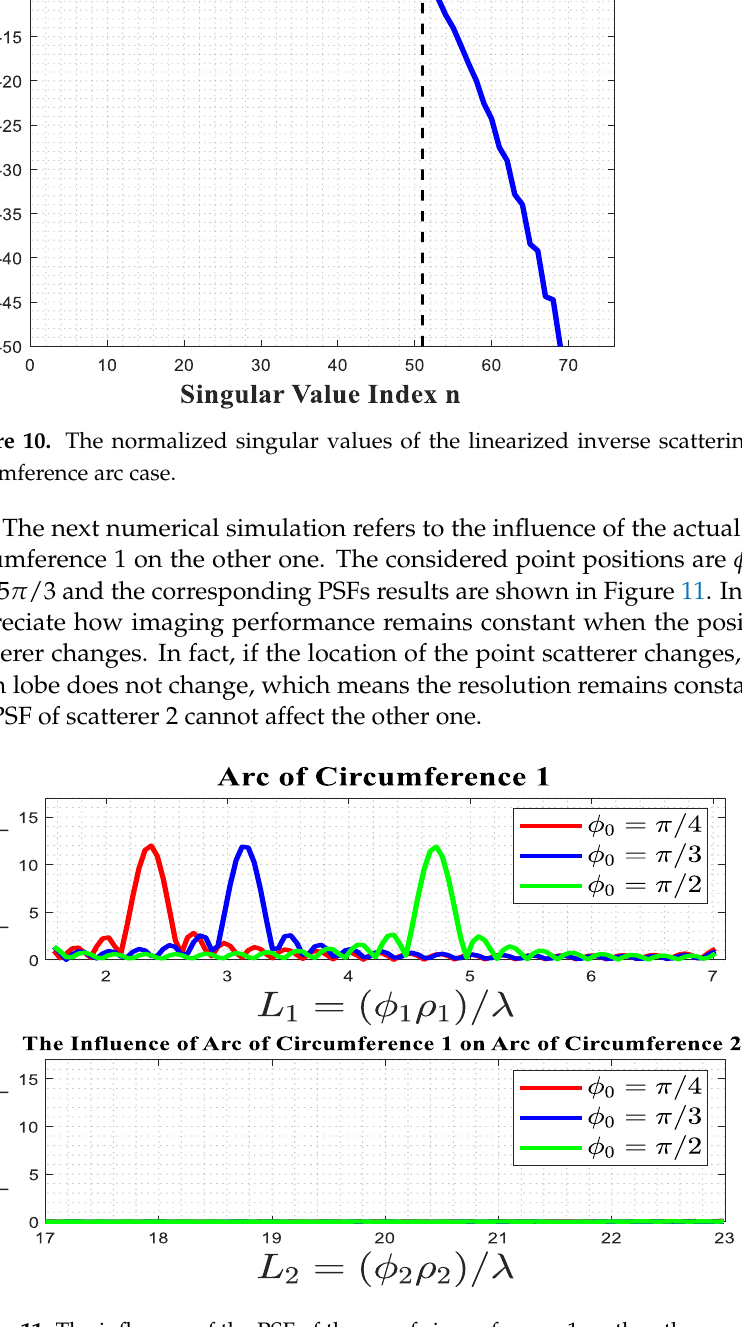
Figure 11. The influence of the PSF of the arc of circumference 1 on the other one, with 𝜌 1 = 3𝜆 and 𝜌 2 = 4𝜆 .